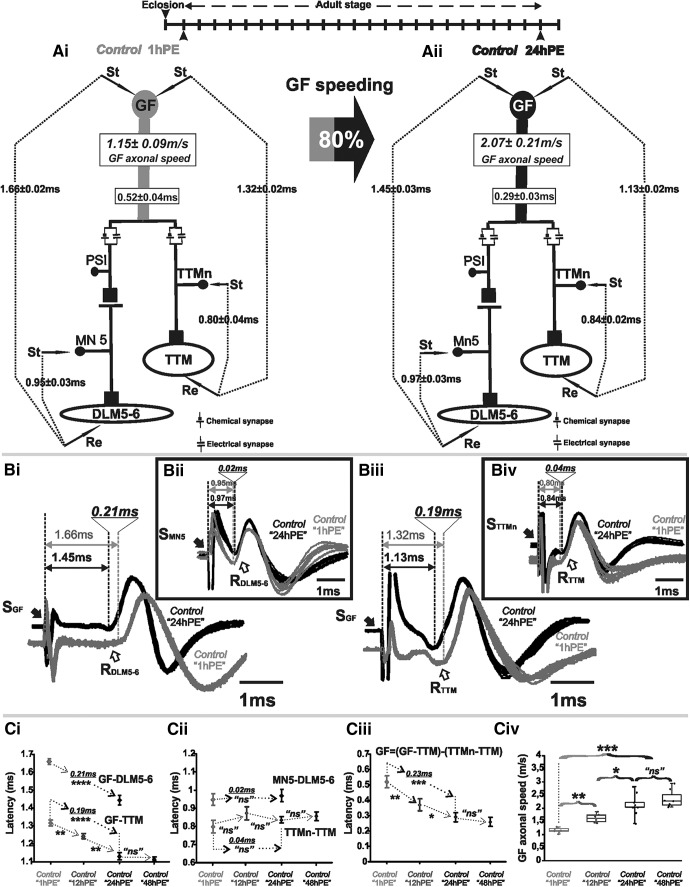

The GF axonal conduction velocity increases 80% during postnatal maturation. A, GFS schematic depiction at 1hPE (Ai) and 24hPE (Aii) control flies. Average latency ± SEM for GF-DLM5–6, GF-TTM, MN5-DLM5–6, and TTMn-TTM branches are indicated between dotted lines. Lower boxes on GF indicate the latency in the GF axon. Upper boxes on GF indicates the GF axonal speed. The percentage of the GF speeding (80%) during the first day of the fly life is presented in the gray-black arrow. B, Ten overlapping sweeps of APs recorded from DLM5–6 muscles, after GF (Bi) or MN5 (Bii) stimulation, and from TTM muscle, after GF (Biii) or TTMn (Biv) stimulation, at 1hPE (gray) and 24hPE (black) flies. Times above double arrows indicate the latency, which is measured as the interval of time between the stimulus artifact (black arrow) and the onset of the initial phase of muscle potential (white arrow). Underlined time values show the difference in latency measurements between the two stages. C, Latency measurements in the GF-DLM5–6 and GF-TTM pathways (Ci), in the MN5-DLM5–6 and TTMn-TTM sub-pathways (Cii), in the GF axon (Ciii), and measurements of the GF axonal speed (Civ), at 1hPE (50% black), 12hPE (70% black), and 24hPE or 48hPE (black) flies. Underlined time values between dotted arrows indicate the latency difference between1hPE and 24hPE. Data are shown as means ± SEM (Ci–Ciii). Dots on box plots showcase the measurements from individual flies (Civ). Asterisks indicate p values from one-way ANOVA with post hoc Dunnett’s tests (*p < 0.05, **p < 0.01, ***p < 0.001, ****p < 0.0001, n.s., p > 0.19). St, stimulation site; Re, recording site; S, stimulus; R, record.